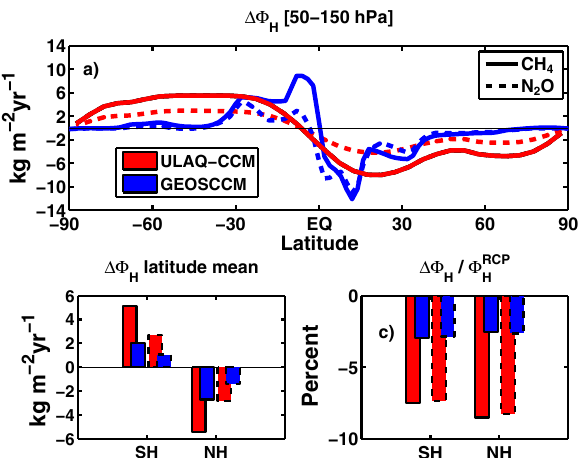
Figure 7. (a) Latitude dependent CH 4 (solid line) and N 2 O (dashed line) vertical mass flux anomalies G4-RCP4.5 from the ULAQ- CCM (a) and GEOSCCM calculations, in red and blue, respec- Figure 9. G4-RCP4.5 anomalies of sulfate aerosol surface area den- tively (vertical average 5–50hPa; time average 2040–2049). Units sity (a, b) and mass density (c, d) in the upper troposphere and low- are kgkm − 2 yr − 1 . Panels (b, c) show the corresponding latitude ermost stratosphere from ULAQ-CCM (a, c) and GEOSCCM (b, d) averaged mass flux anomalies (absolute and percent values, respec- (time average 2040–2049). ULAQ-CCM results are from numerical tively): SH from 90 to 20 ◦ S; tropics from 20 ◦ S to 20 ◦ N; NH experiments (c) in Table 1. Units are µm 2 cm − 3 for the surface area from 20 to 90 ◦ N. The vertical flux anomalies (cid:49)(cid:56) V are defined and µgm − 3 for the mass density. In panels (a, b) , the contour line as (cid:49) [ w ∗ ρ CH ] and (cid:49) [ w ∗ ρ N ], where w ∗ is the zonal mean resid- 4 2 O increment is 0.5 for values less than 12 and 2.0 from 14 to larger ual vertical velocity, ρ CH and ρ N are the mass concentrations of 4 2 O values. In panels (c, d) , the contour line increment is 0.1 for values CH 4 and N 2 O, respectively, and (cid:49) denotes the G4-RCP4.5 differ- less than 2.5 and 1.0 from 3.0 to larger values. ence. ( a) Δ NO x ( ppbv ) [G4(FBC)−RCP4.5]